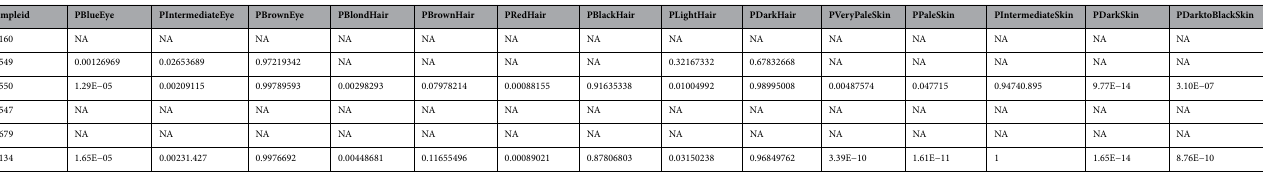
Table 6. Likelihood of eye, hair and skin pigmentation phenotypes under the HIrisPlex-S model.